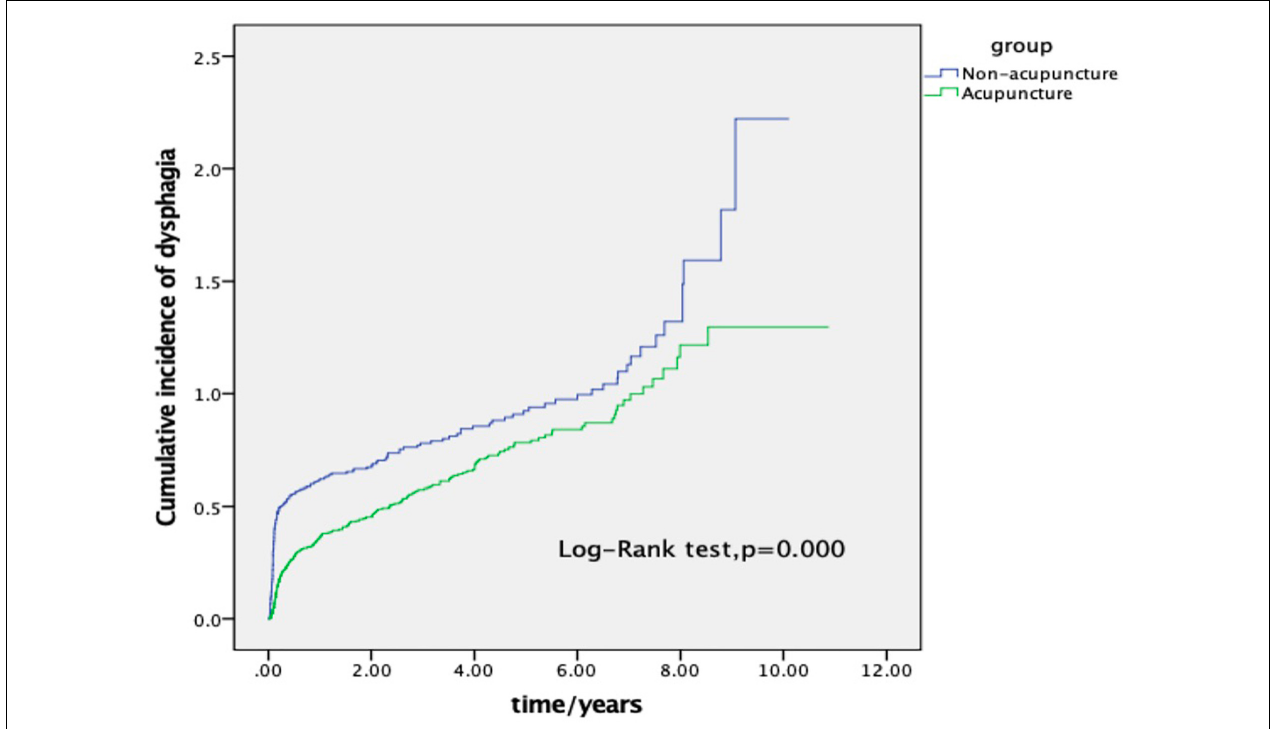
FIGURE 2 | Cumulative incidence of insomnia between the acupuncture and non-acupuncture cohorts of stroke patients. As shown in the figure, the cumulative incidence of the acupuncture cohort was significantly lower than that of the non-acupuncture cohort (log-rank test, p = 0.000).